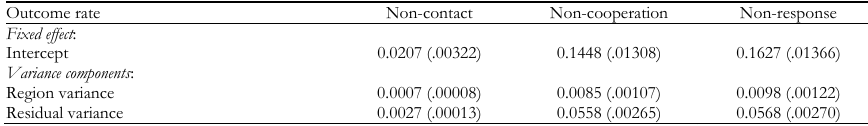
Null model for non-contact, non-cooperation and non-response rates: solutions for fixed and random effects – 2005 Outcome rate Non-contact